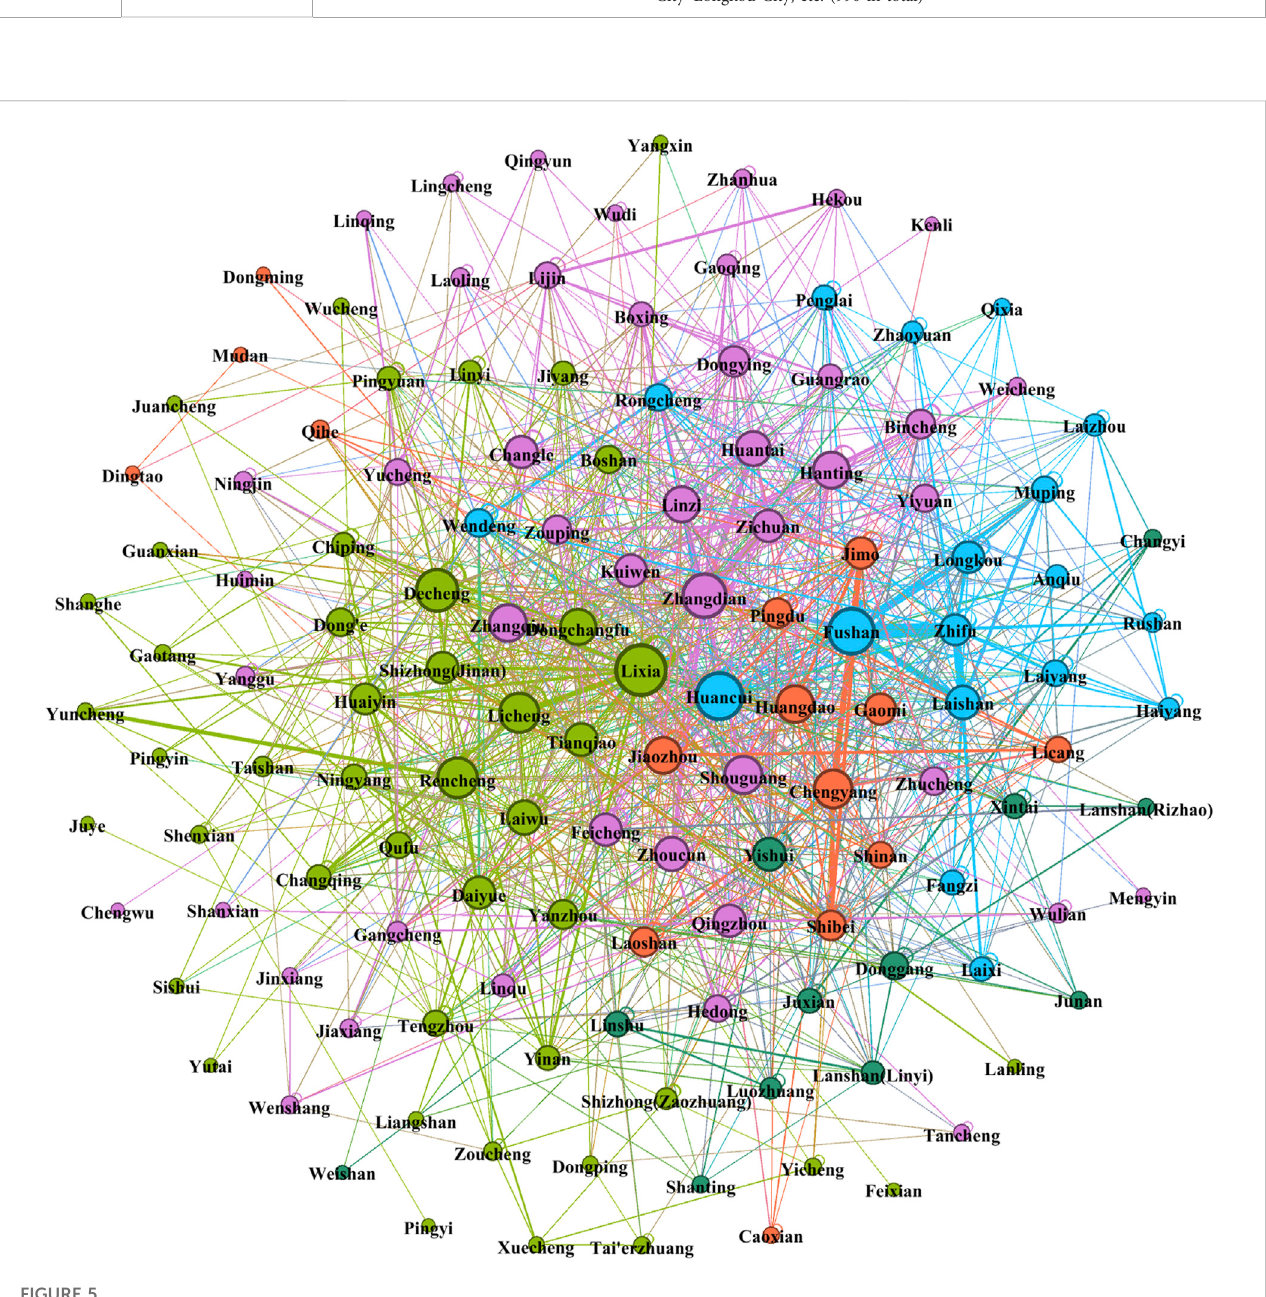
FIGURE 5 City Supply Network Pattern of Shandong (Fruchterman Reingold